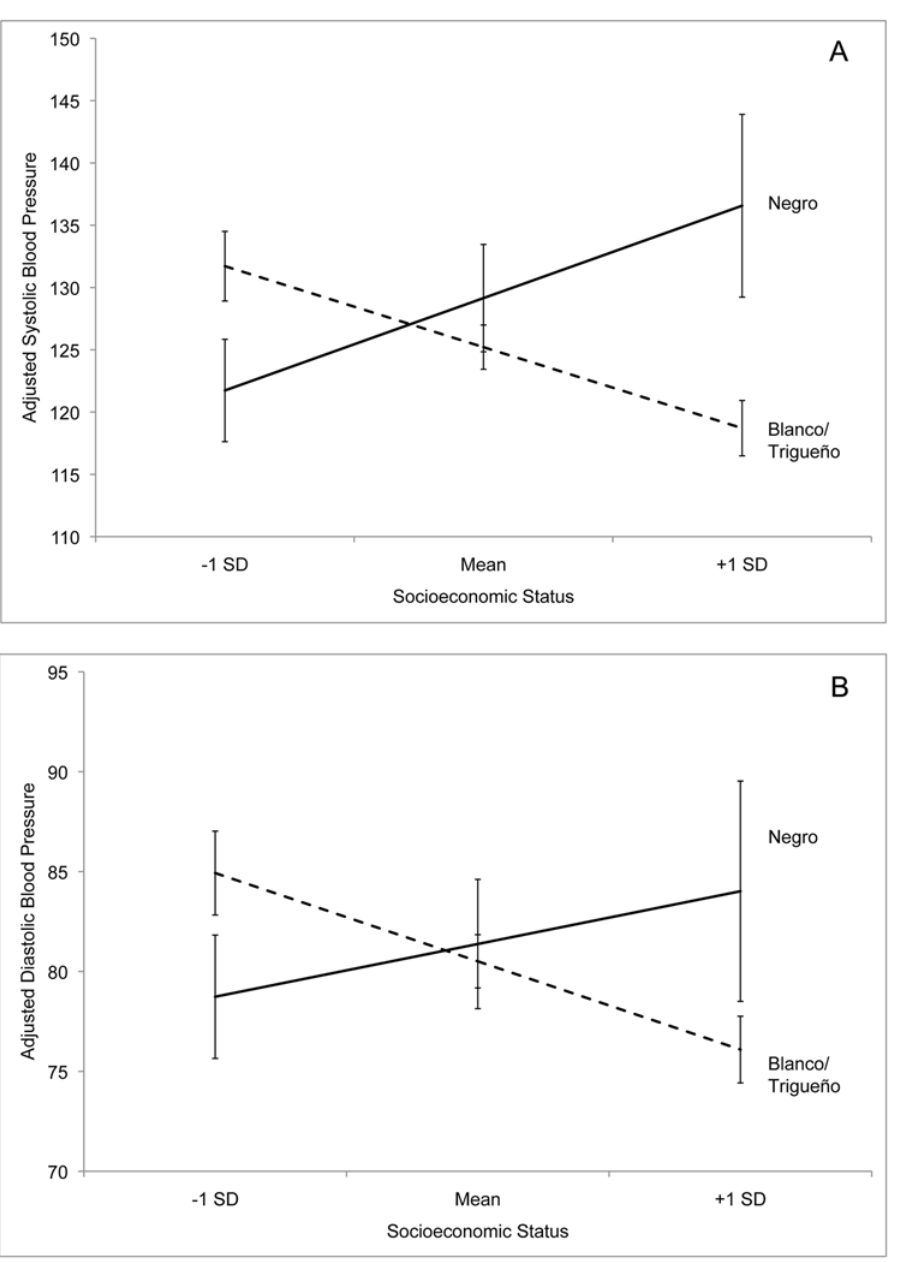
Figure 2. Interaction effect between culturally ascribed color and socioeconomic status for (A) systolic blood pressure and (B) diastolic blood pressure, adjusted for age, sex, body mass, use of antihypertensive medications, and genetic